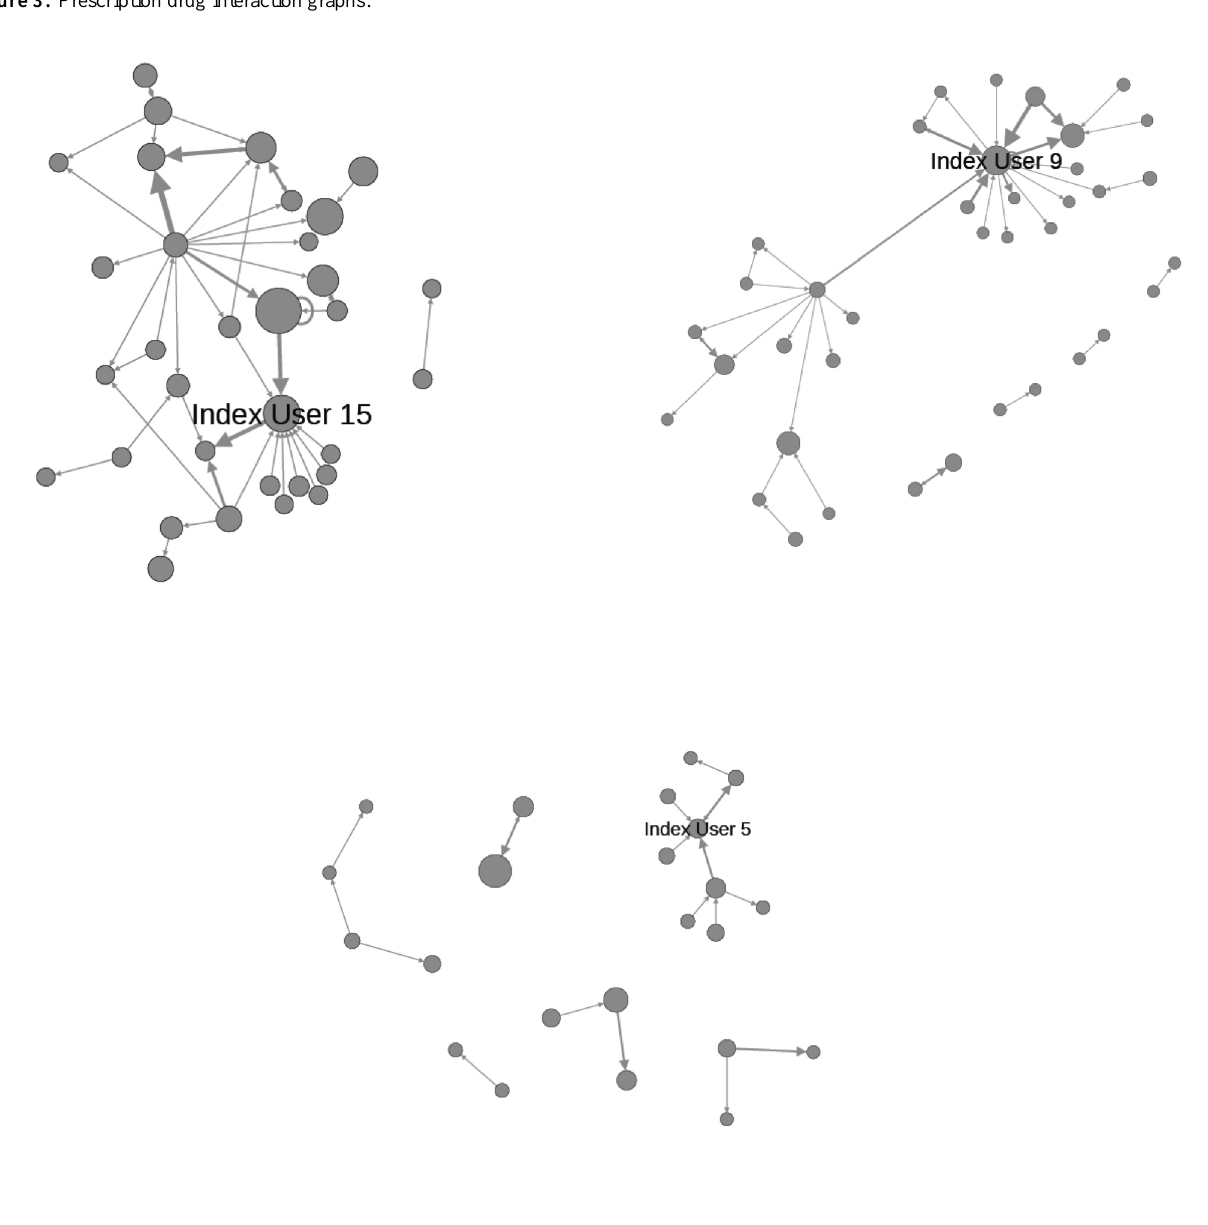
Figure 3. Prescription drug interaction